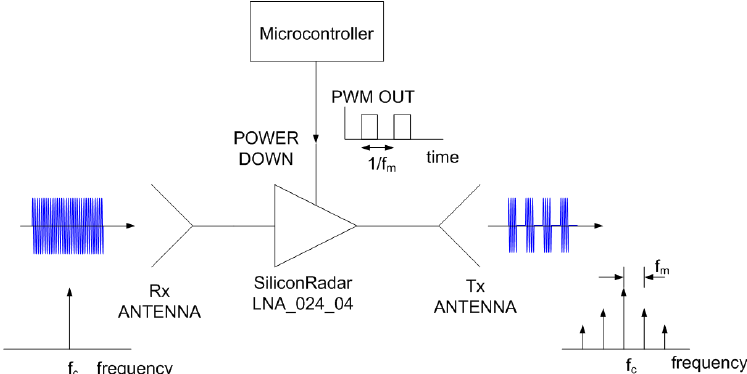
Figure 2. Block diagram of the modulated backscatter.